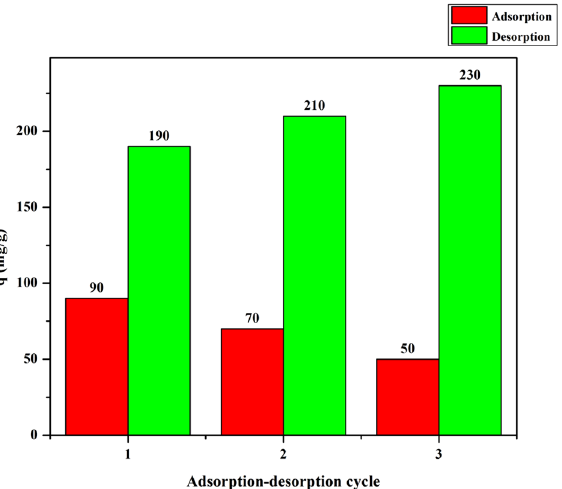
Figure 16. Adsorption/desorption with repeated cycles on GFLE; Initial concentration 280 mg L −1 Cu (II), pH = 1, time 105 min and temperature 313 K.